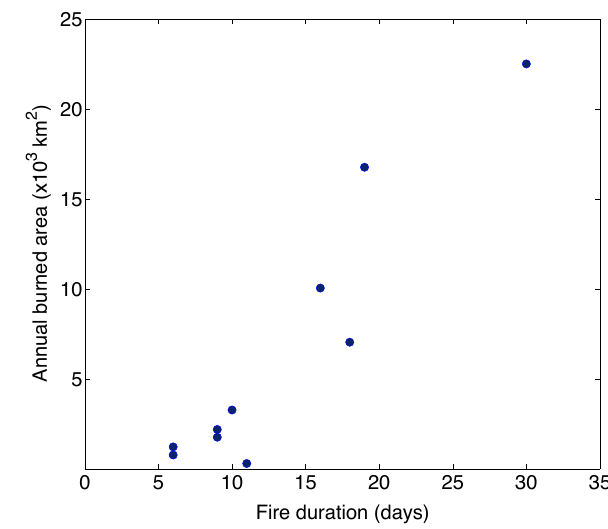
Figure 11. Scatterplot of fire season length against annual burned area for 2002–2011 extracted from Alaska LFDB and subtracting unburnt islands within fire